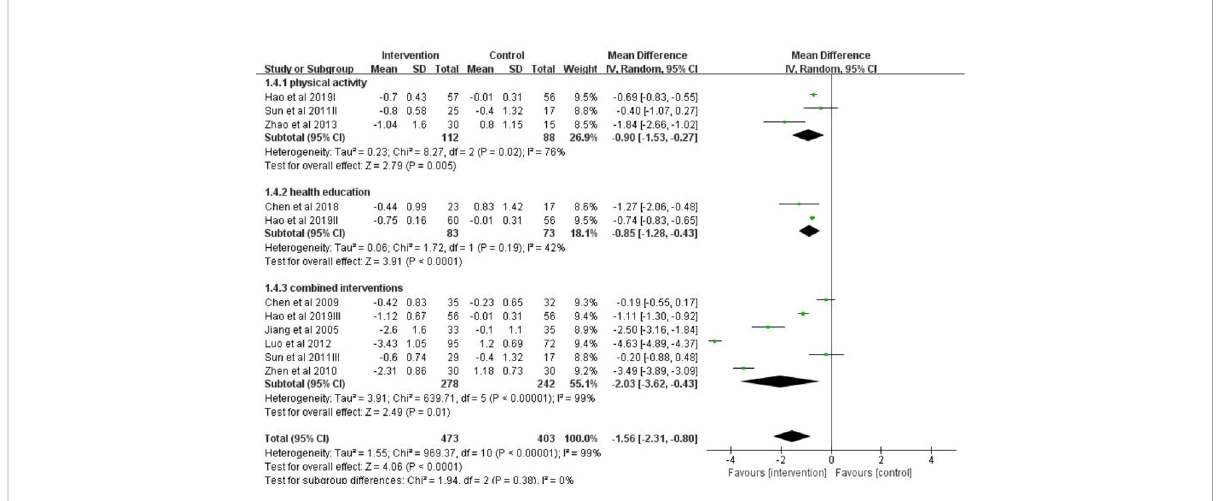
FIGURE 4 A forest plot providing data on the impact of lifestyle interventions on BMI with 95% con fi dence intervals of individual studies, grouped by intervention type. Using a random effects model and an inverse variance method, a summary estimate of the 95% con fi dence interval was calculated. SD, standard deviation; IV, inverse variance; CI, con fi dence